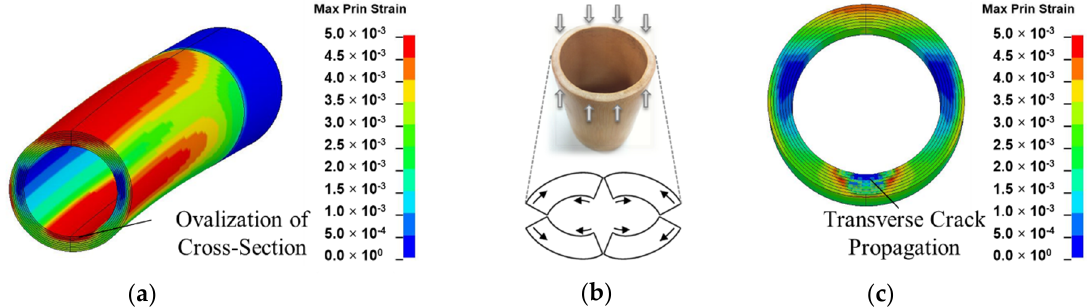
Figure 14. Failure mechanisms of bamboo in bending: ( a ) ovalization of internode cross-section as